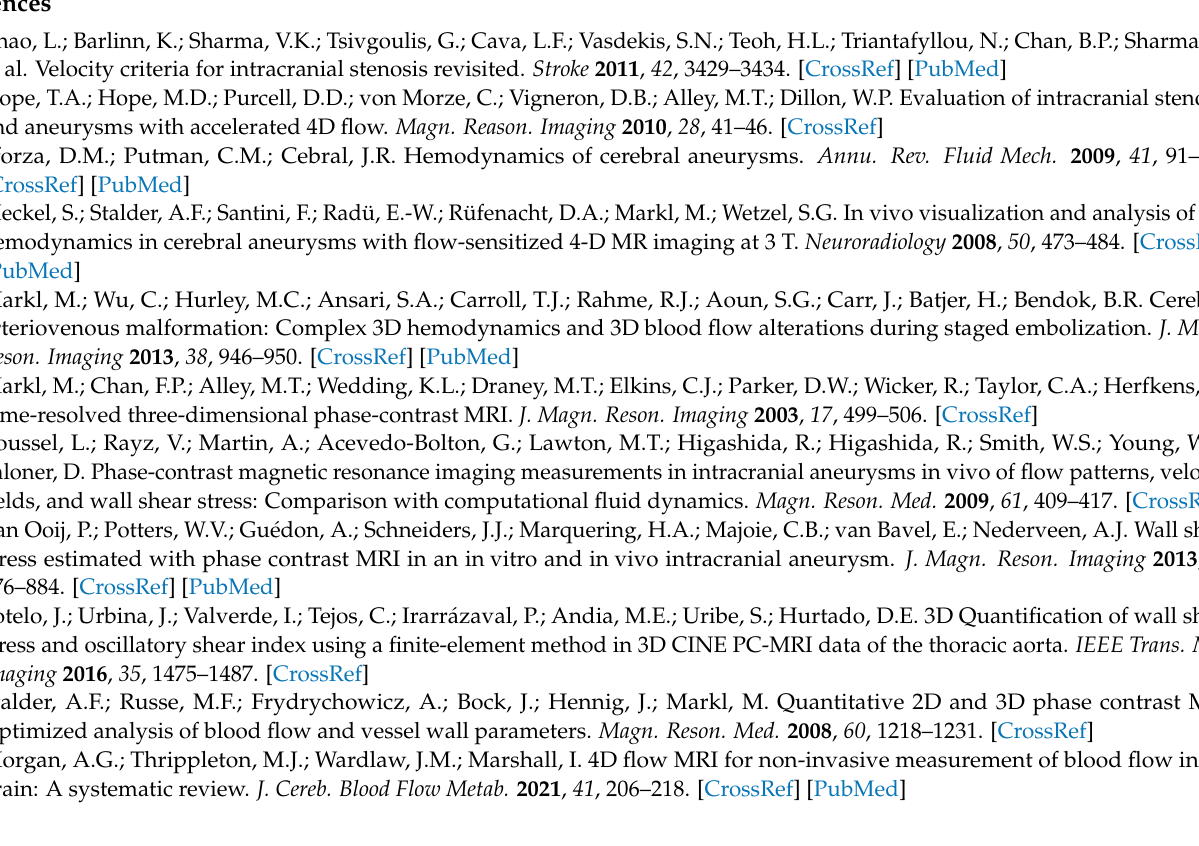
rates obtained with 4D flow MRI and US sensor, 4D and 2D flow MRI. Table S7: Summary statistics for velocity distribution in aneurysm sac obtained with 4D flow